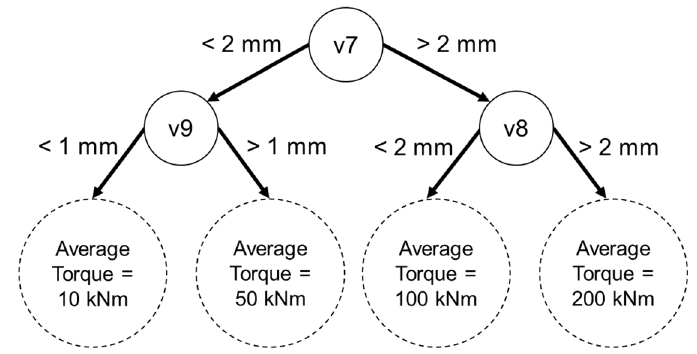
Figure 3. Example regression decision tree.